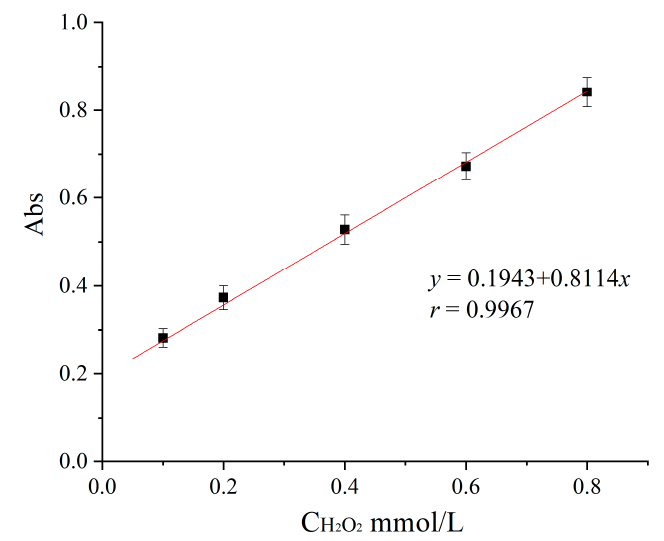
Figure 9. Linear plots of the SQA-iron(II/III) system toward H 2 O 2 standards with various final concentrations.